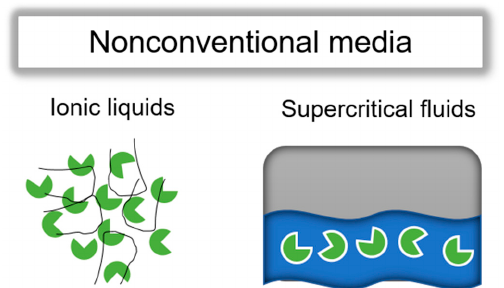
Figure 2. Various non-conventional media and non-aqueous solvents for the immobilization of enzymes.